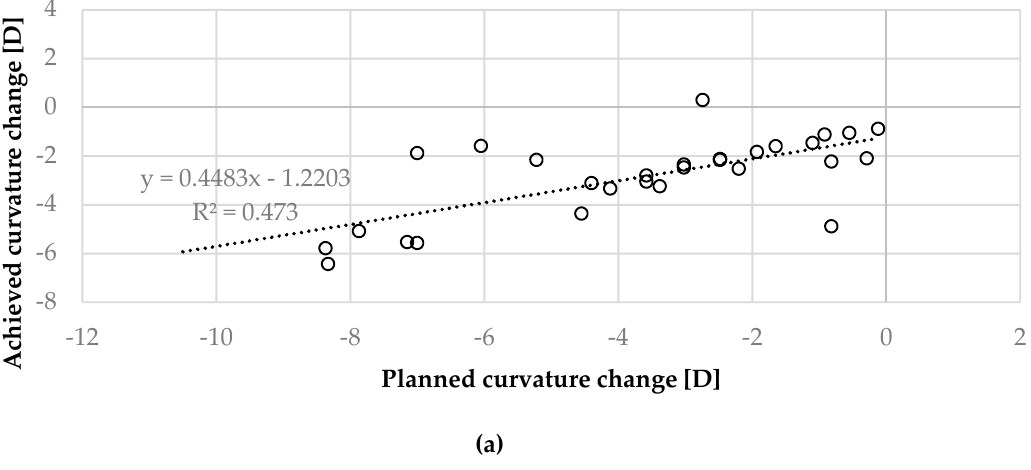
Figure 2. Double ‐ angle polar plots comparing ( a ) pre ‐ to ( b ) postoperative astigmatism. Myopia results are shown as circles and presbyopia results are shown as solid squares. No obvious differences between myopia and presbyopia correction were visible.